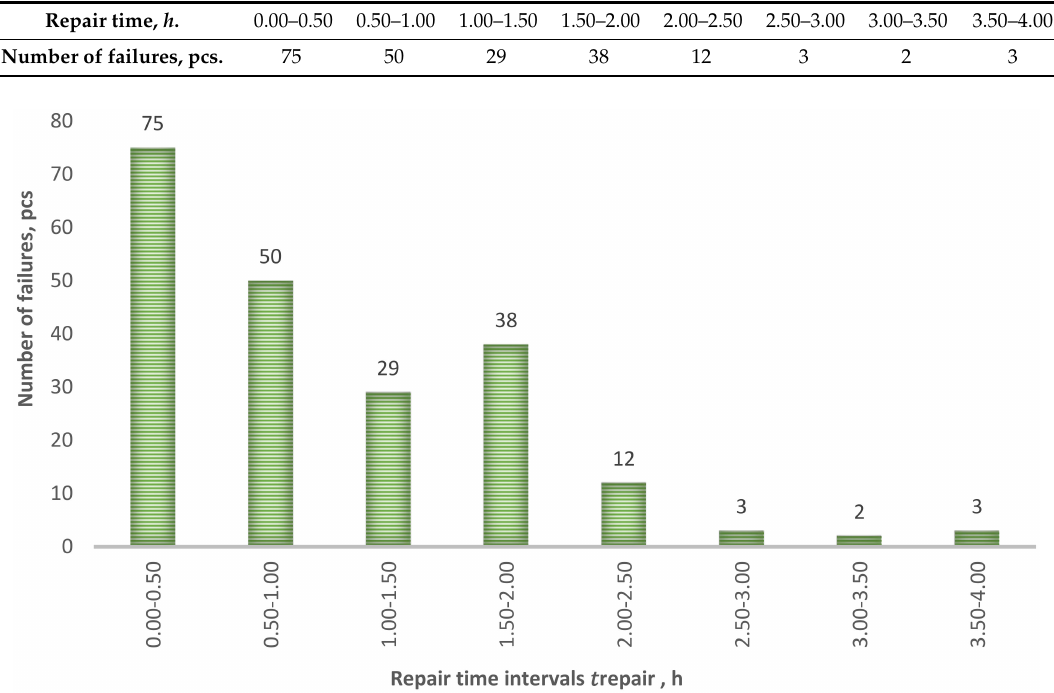
Table 3. Number of failures for specific repair time.